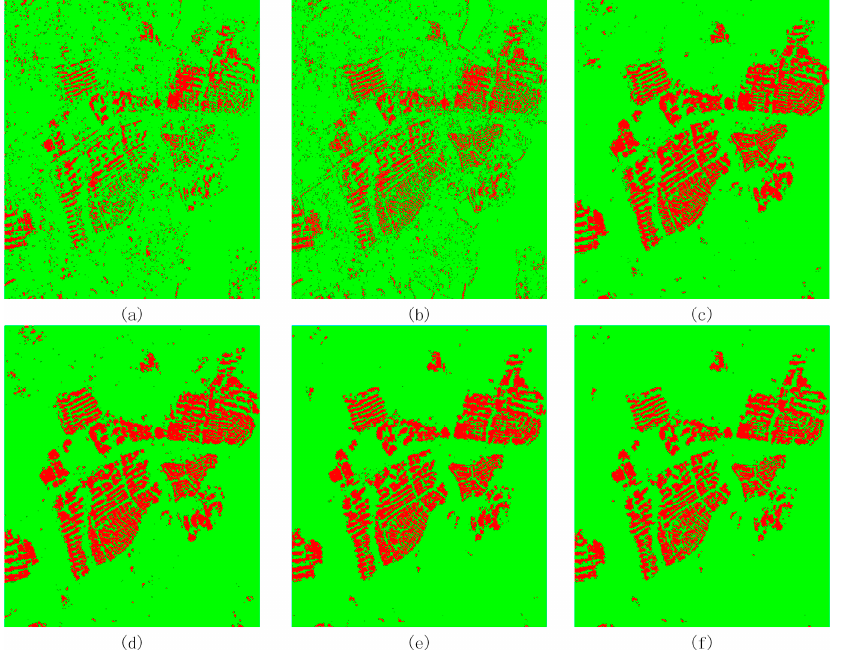
Figure 5. GF-3 image building extraction results. ( a ) Quan’s threshold extraction method; ( b ) PauliRGB and G 0 statistical texture parameters using SVM results; ( c ) RVCNN; ( d ) PFDCNN; ( e ) PauliRGB and G 0 Statistical texture parameters using CNN; ( f ) as the result of introducing superpixel constraints in ( e ). Table 2. Different methods of building extraction effects under GF-3 data.